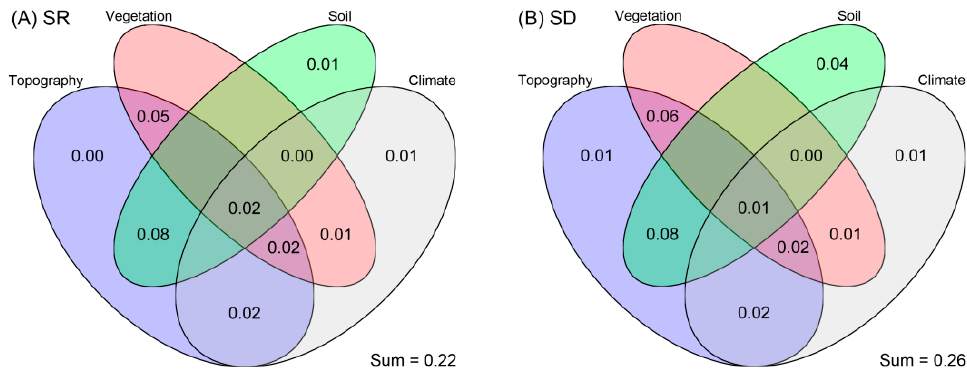
Figure 5. Variation partitioning of four environmental variable groups for ( A ) species richness (SR) and ( B ) species density (SD) of orchids in Jiangxi. The four groups of environmental variables are topography (elevation and slope), vegetation (canopy density and normalized difference vegetation index), soil (pH, total nitrogen, total phosphorus, and total potassium), and climate (annual mean temperature and annual precipitation).